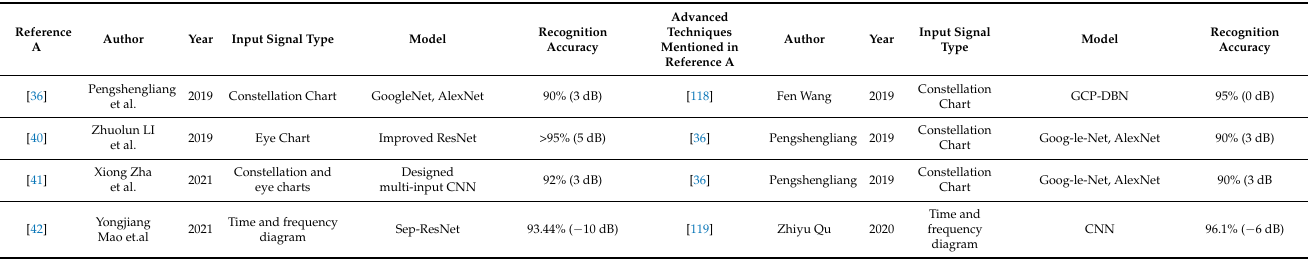
Table 4. Technical comparison table of some